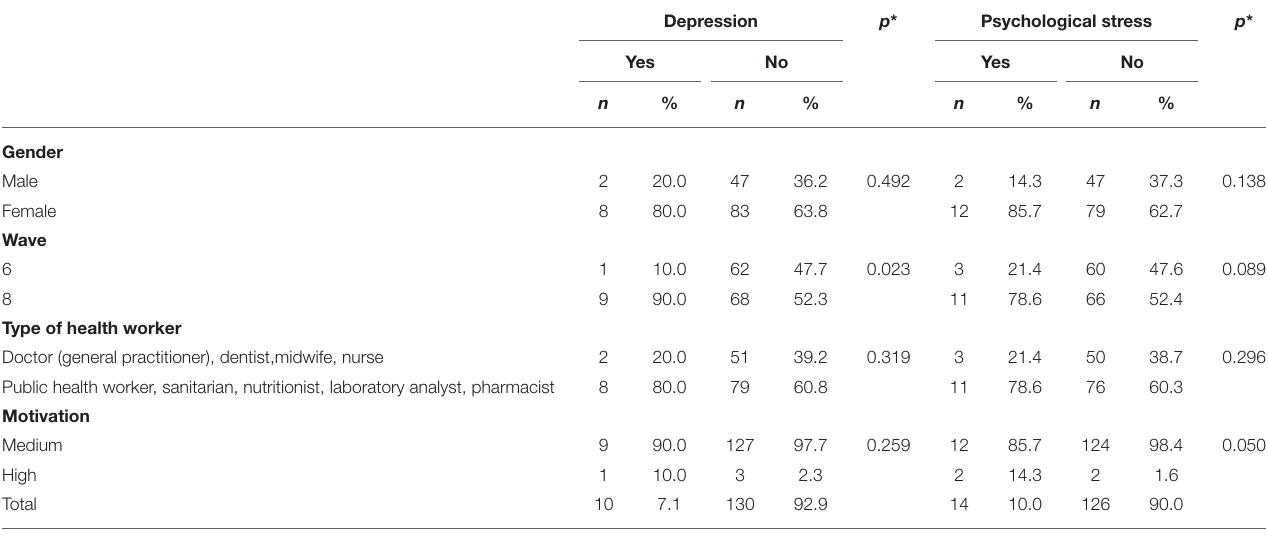
TABLE 2 | Factors related to depression and psychological stress.